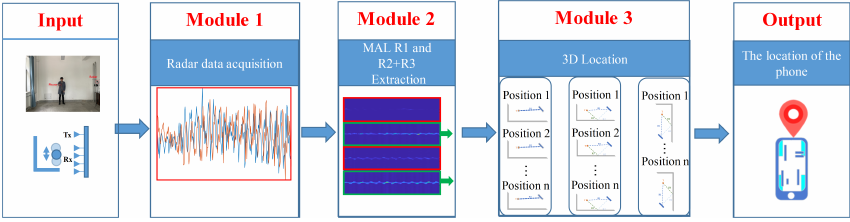
Figure 3. MAL model